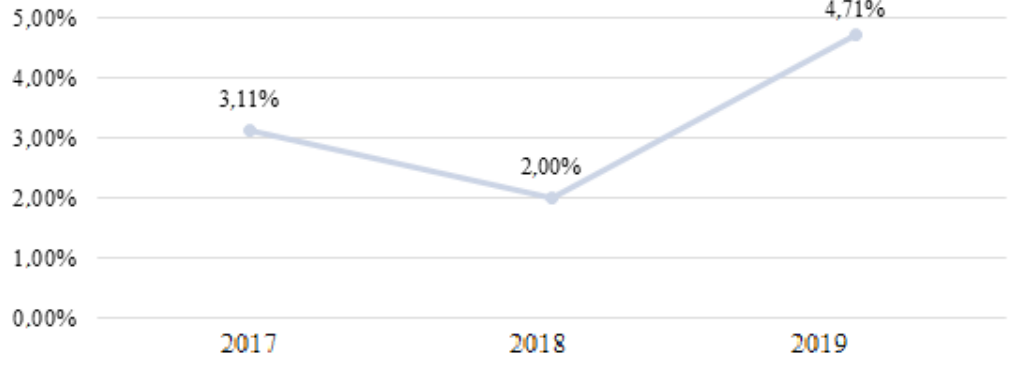
Figure 9. Return on assets of SMEs financed in the